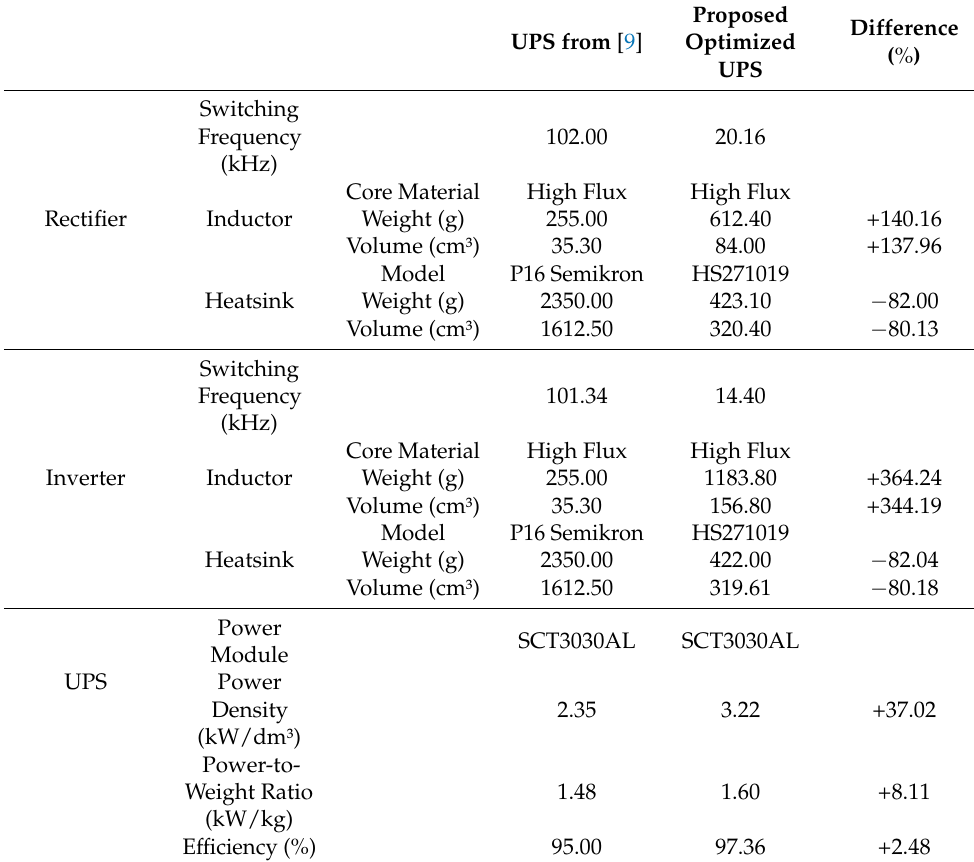
Table 4. Comparison of components’ weight and volume and UPS’s power density and efficiency for the designs obtained with the mCAD tool and with the one developed in